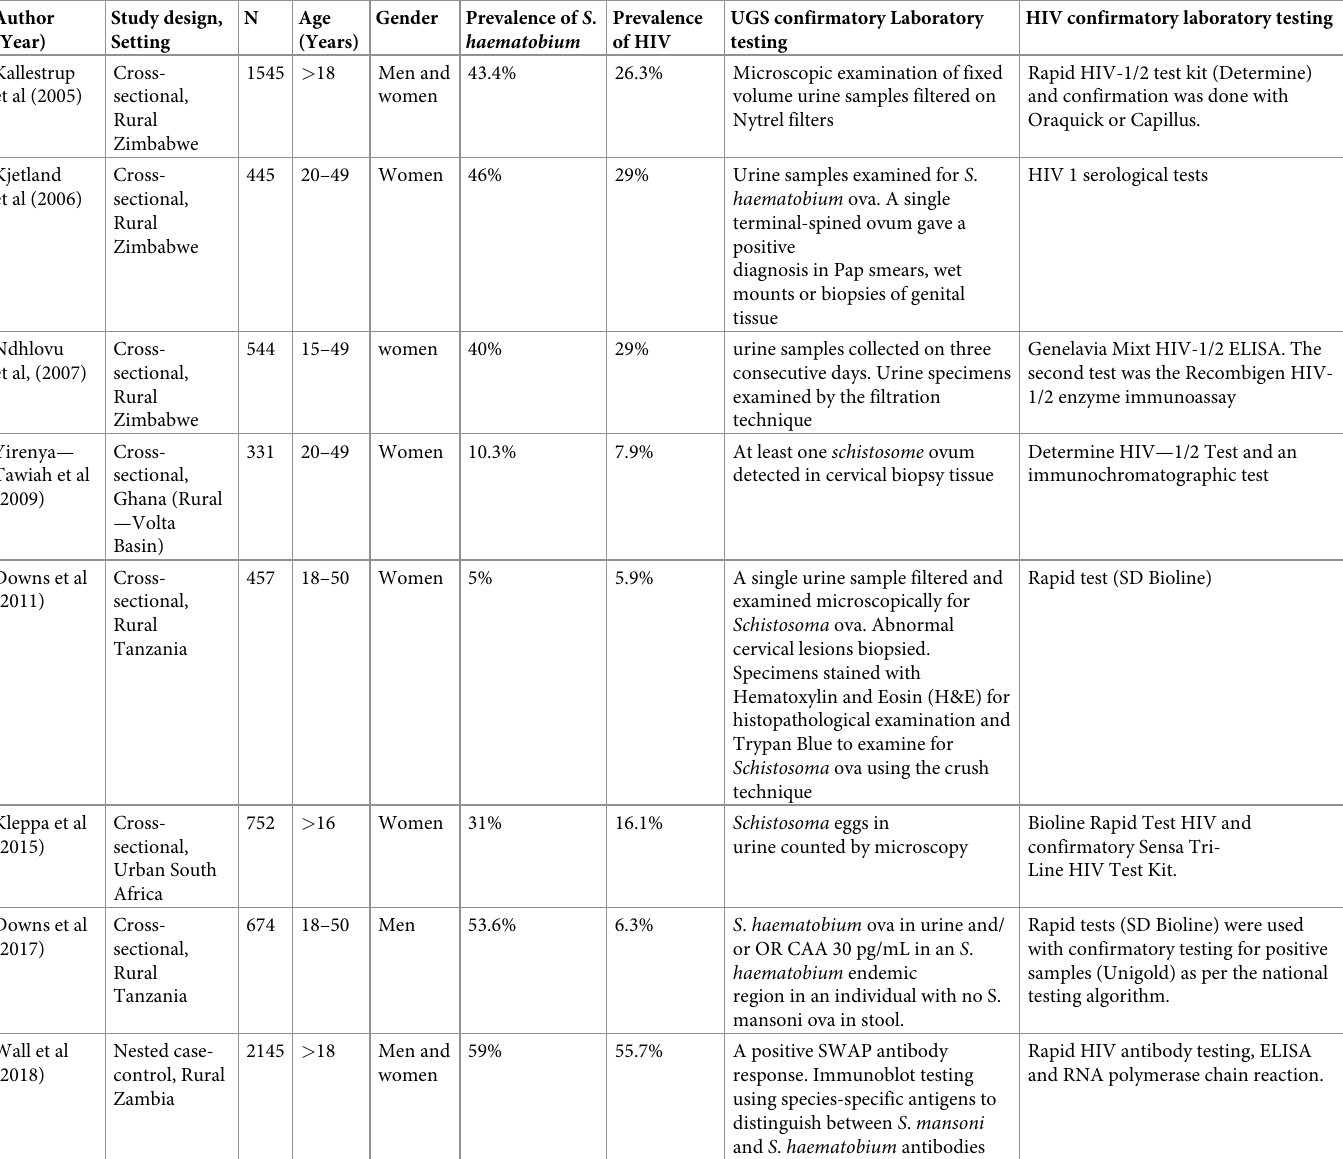
Table 1. Characteristics of 8 eligible studies included in the systematic